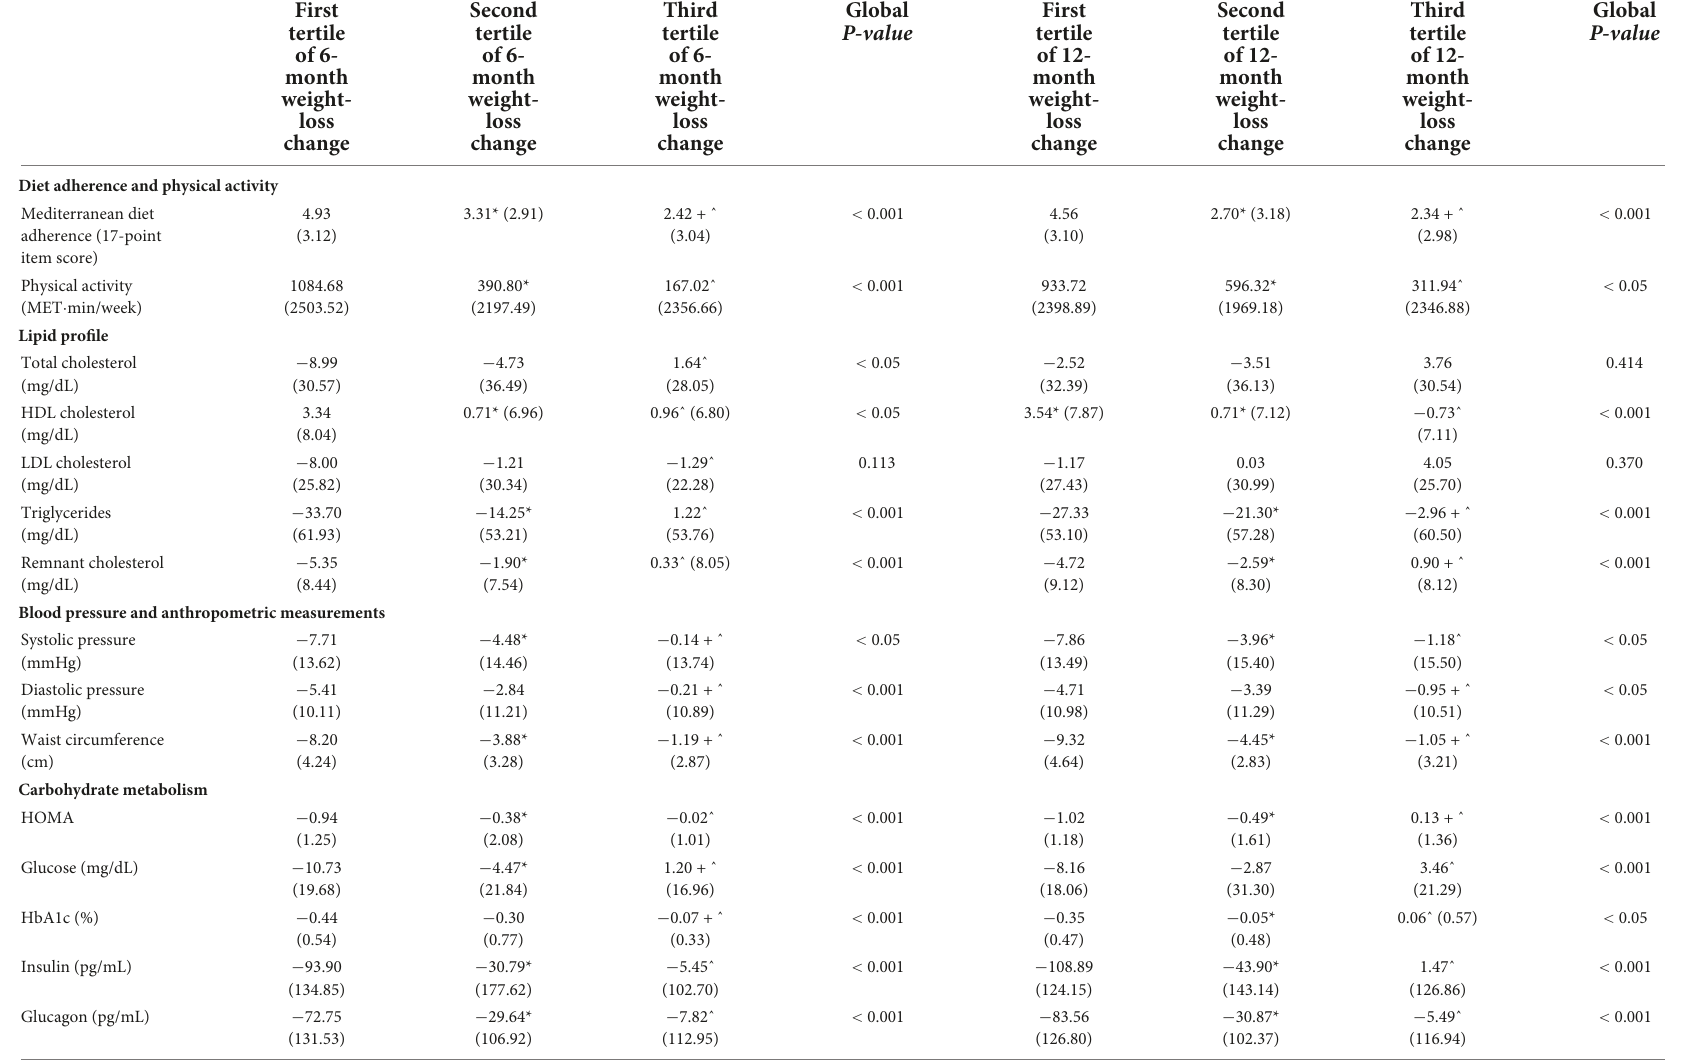
TABLE 3 Tertiles of weight loss change (mean, standard deviation, and their comparison) adjusted for weight and baseline value of the participants on the 17-item questionnaire, physical activity, biomarkers and anthropometric measurements, lipid profile, carbohydrate metabolism, and